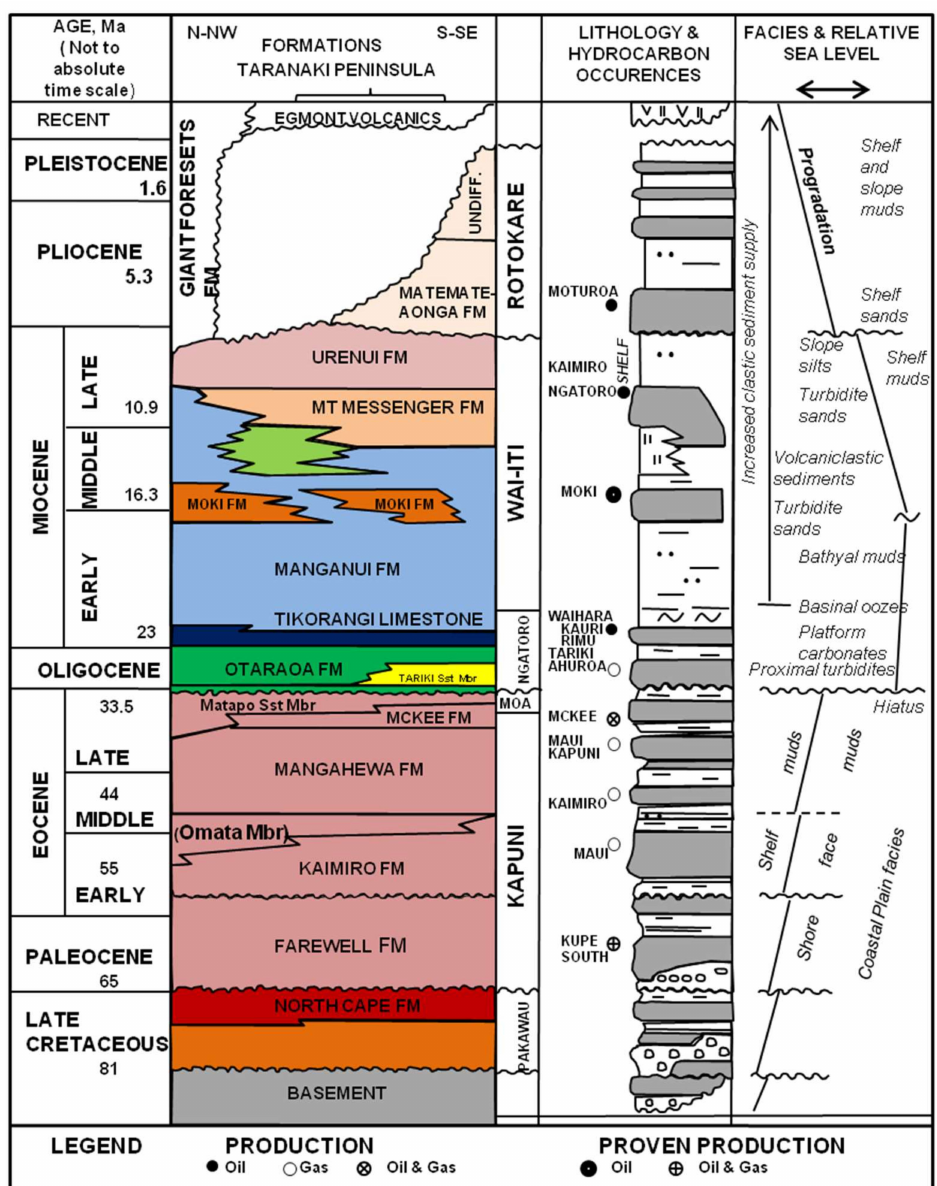
Figure 2. The generalized stratigraphy of the Taranaki Basin; Modified after [17] with permission to reproduce it granted by the Petroleum Exploration Society of